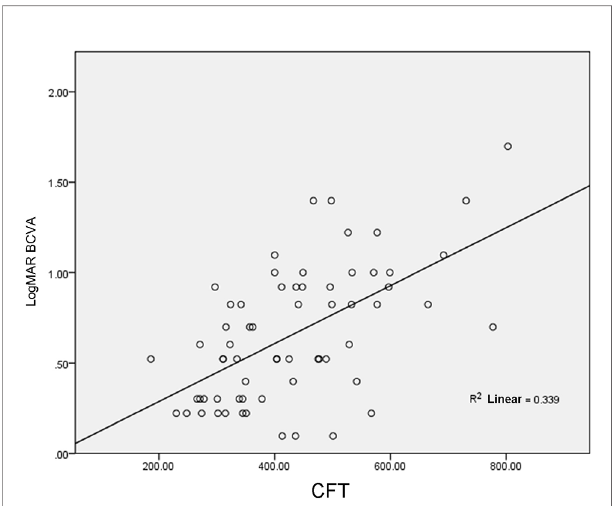
FIGURE 1 | Correlation between CFT and LogMAR